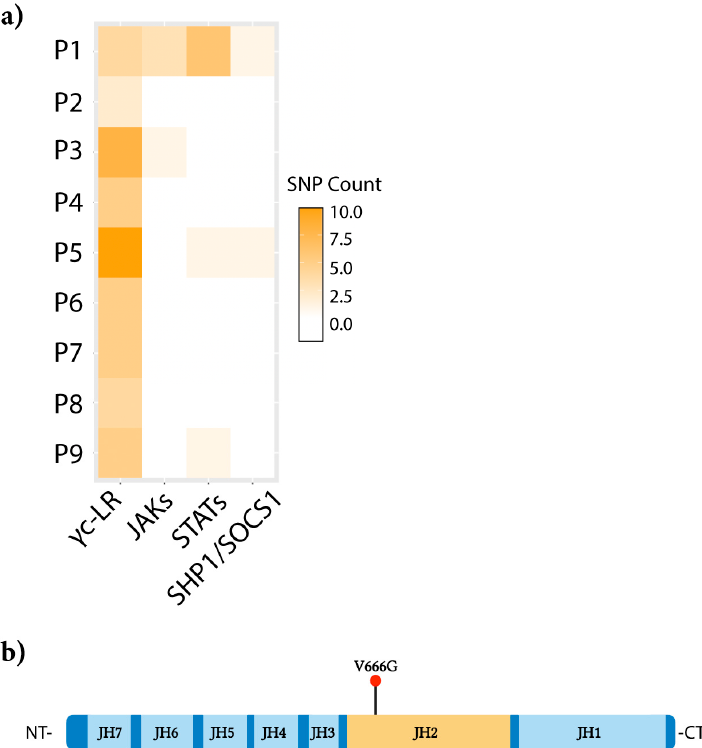
Figure 1. Identification of the JAK1 V666G mutation in an ALL-patient sample. ( a ) The number of non-synonymous ALL SNPs within genes involved in the JAK/STAT pathway across the patient cohort (P1–P9) are represented in a heat map. Common gamma-chain-linked receptors ( γ c-LR), Janus tyrosine kinases (JAKs), signal transducer and activator of transcription (STAT), SH-2 containing inositol 5 ′ polyphosphatase 1 (SHIP1), suppressor of cytokine signaling 1 (SOCS1). ( b ) Linear structure of JAK1, depicting V666G within the JH2 domain (orange). Figure was created with BioRender.com, accessed on 2 February 2023 .